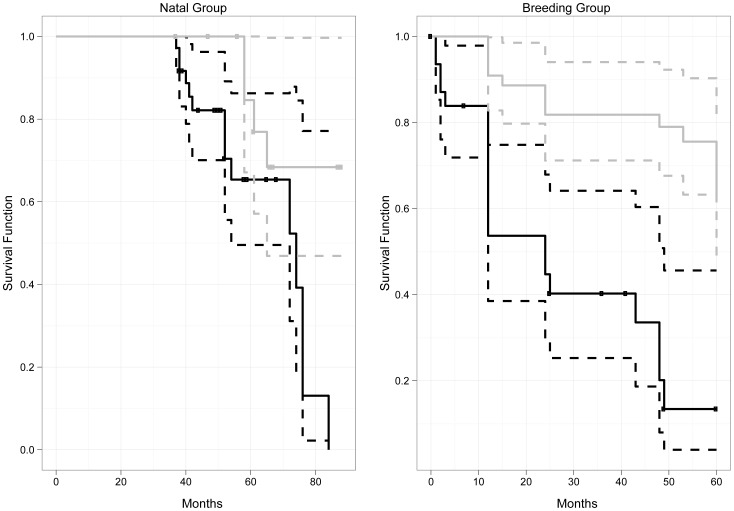
Male and female tenures in natal group and breeding group.The solid lines represent the survival function (i.e. probability of remaining in the current group) and the dotted lines represent the 95% confidence intervals. Dots indicate censored values. Males and females are represented by black versus gray lines.